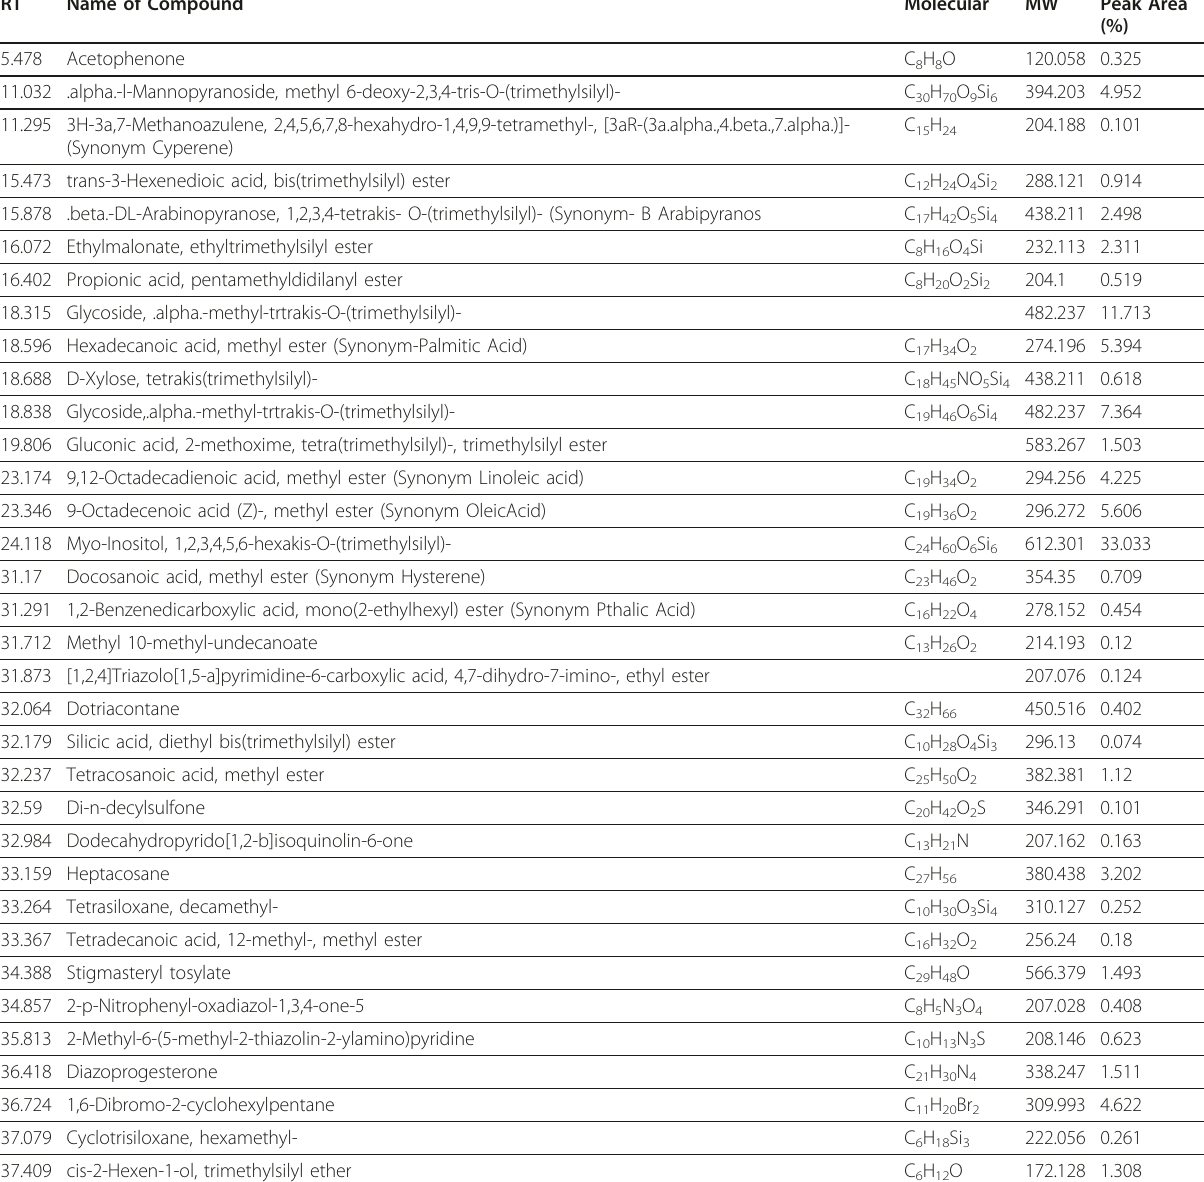
Table 3 Phytocomponents identified in the methanolic extract of flowers of Pyrostegia venusta by GC-MS